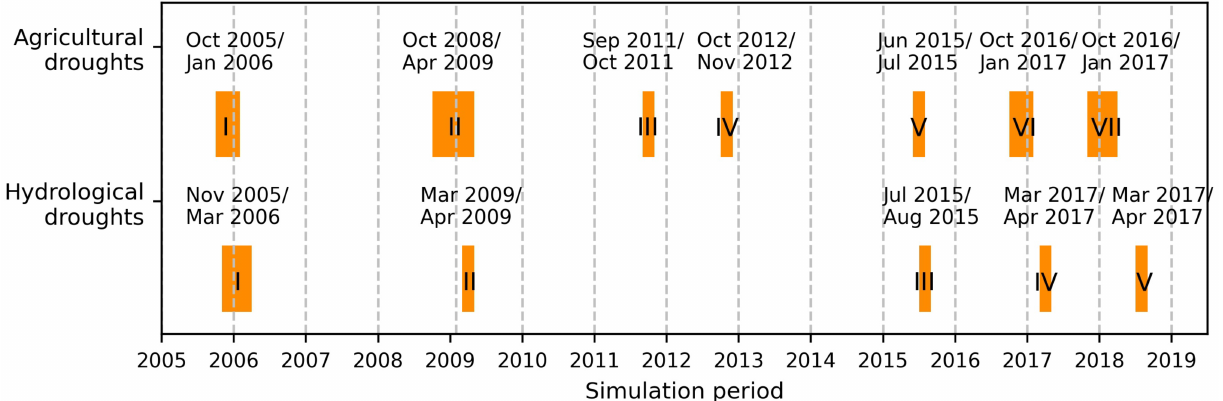
Figure 4. Agricultural and hydrological drought events during the simulation period. Roman numerals indicate the name of the drought event. Agricultural drought events are named from I to VII, and hydrological drought events are named from I to